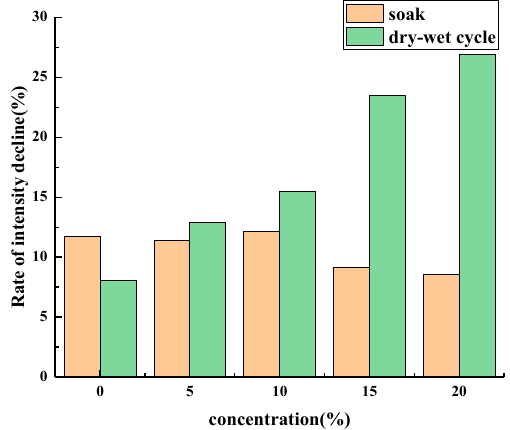
Figure 10. Dry and wet cycle splitting strength.